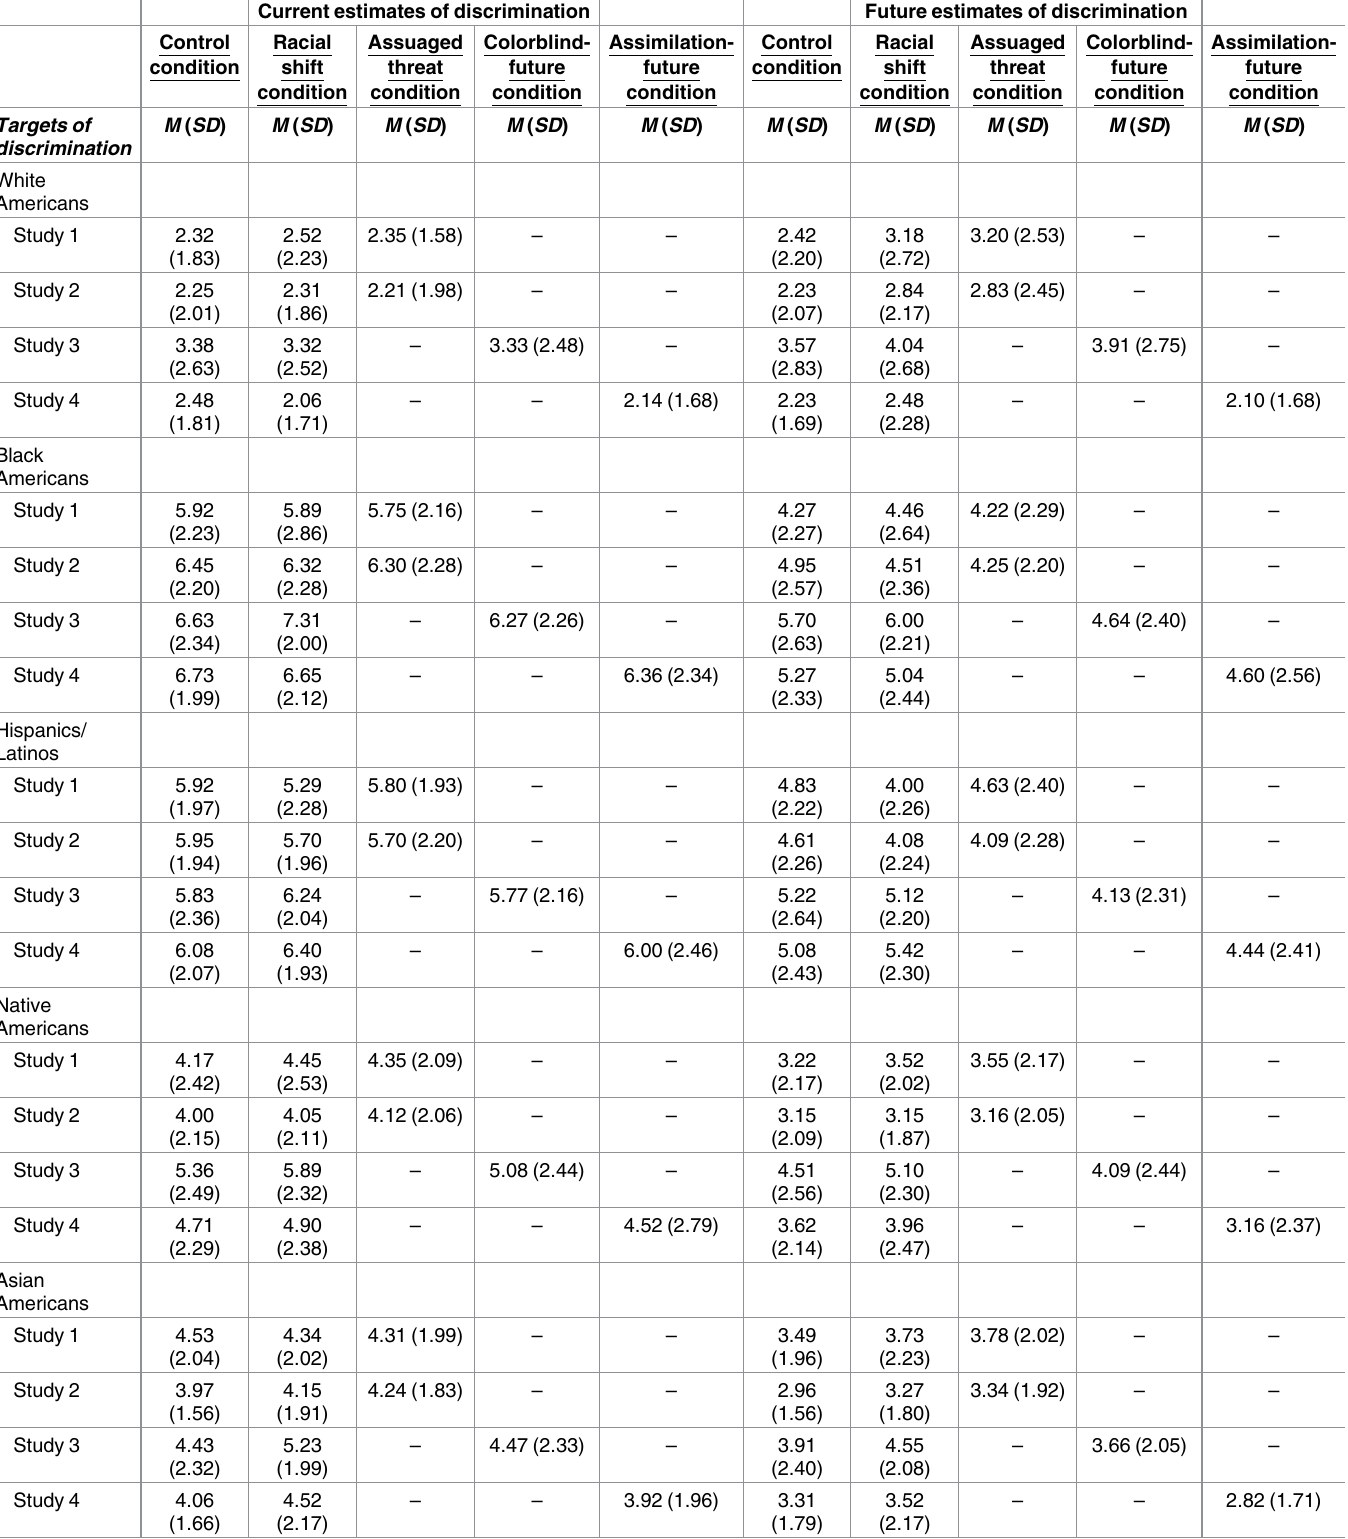
Table 1. Studies 1–4: Descriptive statistics for perceiveddiscrimination by experimental condition and